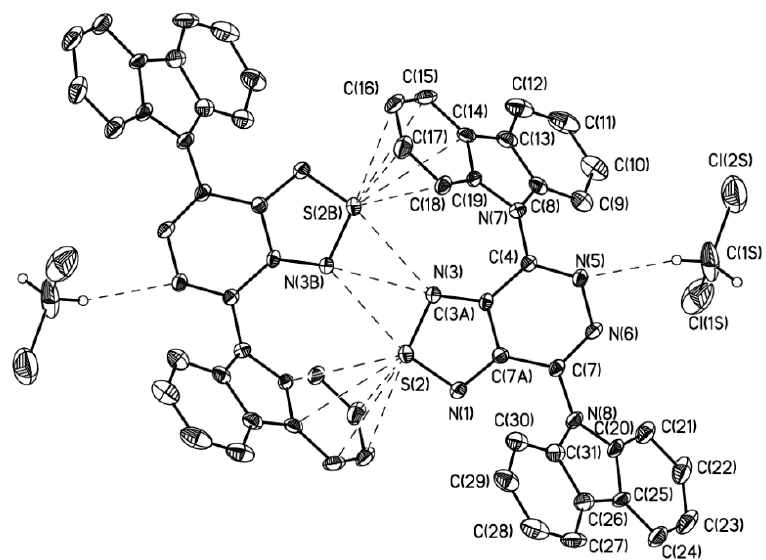
Figure 1. Dimers in the crystal of 16 in representation of atoms by thermal ellipsoids ( p = 50%).